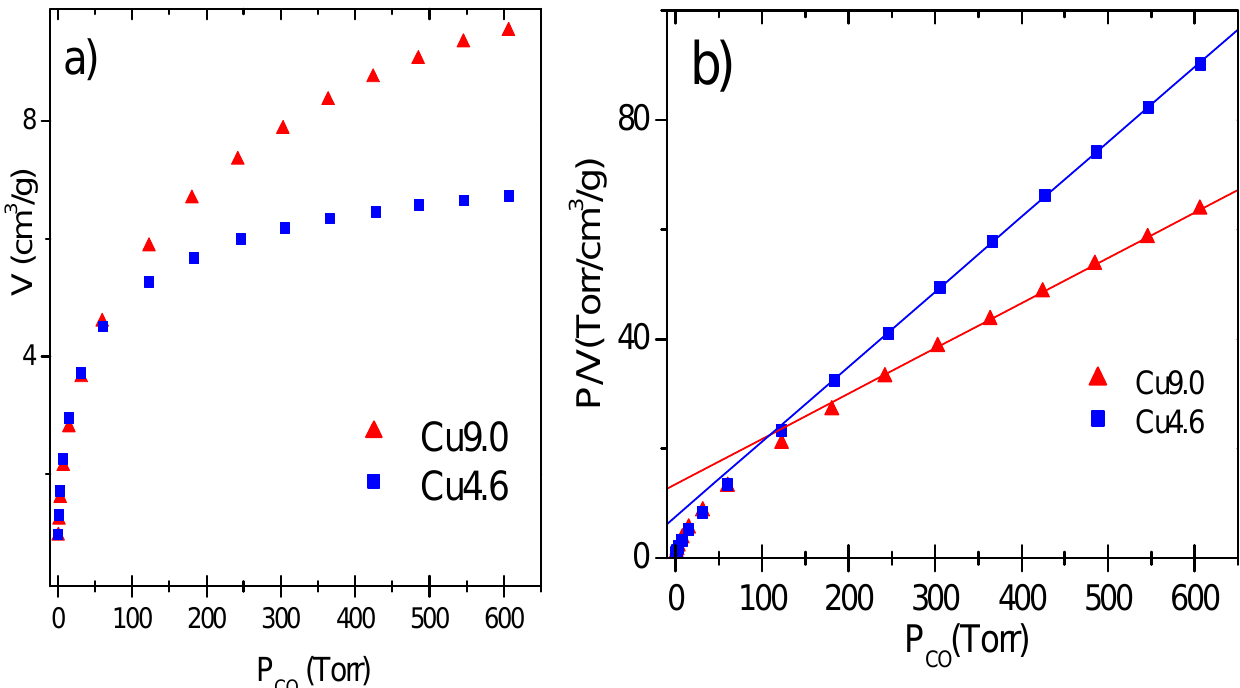
Figure 5. Part a: volumetric data of CO adsorbed at RT on Cu9.0 and Cu4.6 catalysts previously reduced with ethylene at 500 K. Part b: Corresponding Langmuir plots.